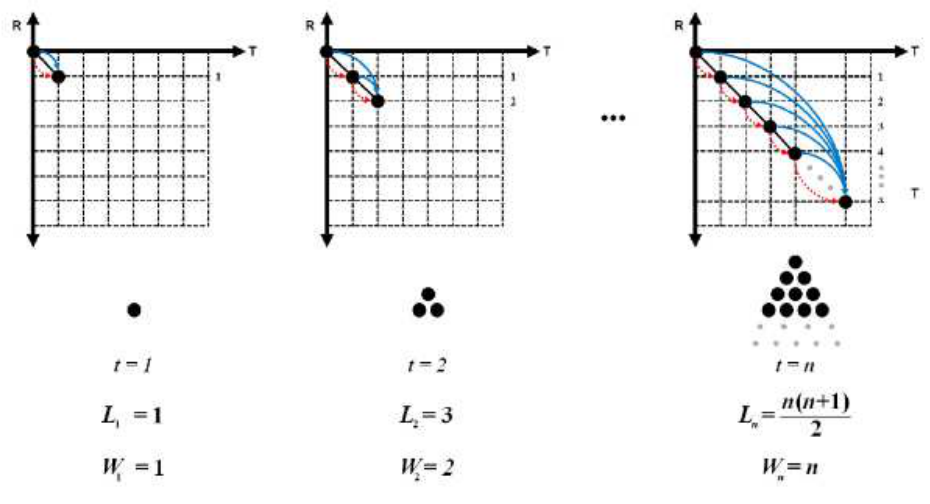
Figure 2. GTP ruin accumulation